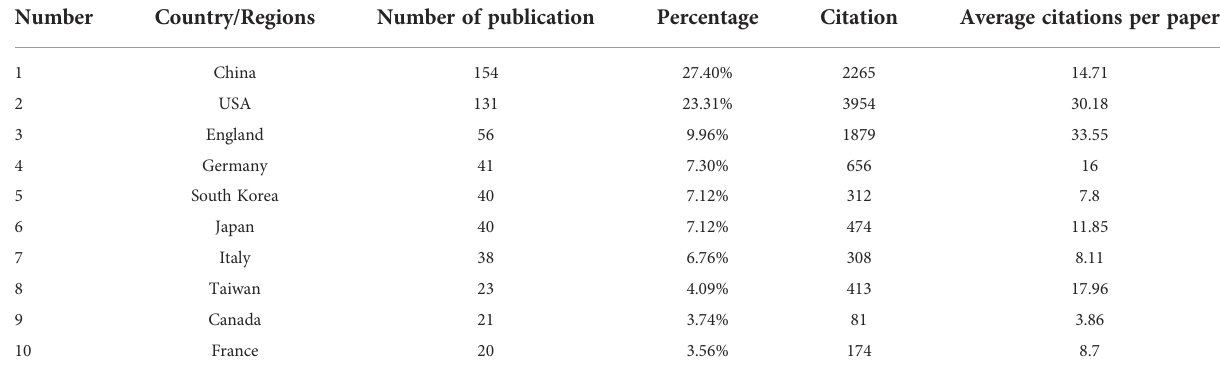
TABLE 1 Top 10 of most produtive